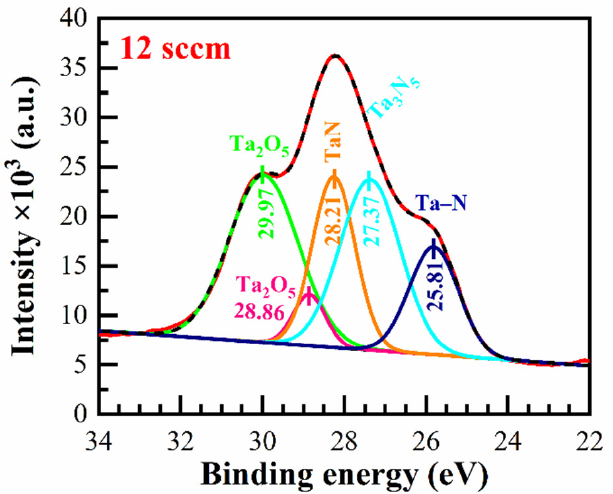
Figure 7. Deconvoluted spectra of Ta4f for the TaN films with N 2 flow of 12 sccm for 10 min deposition.